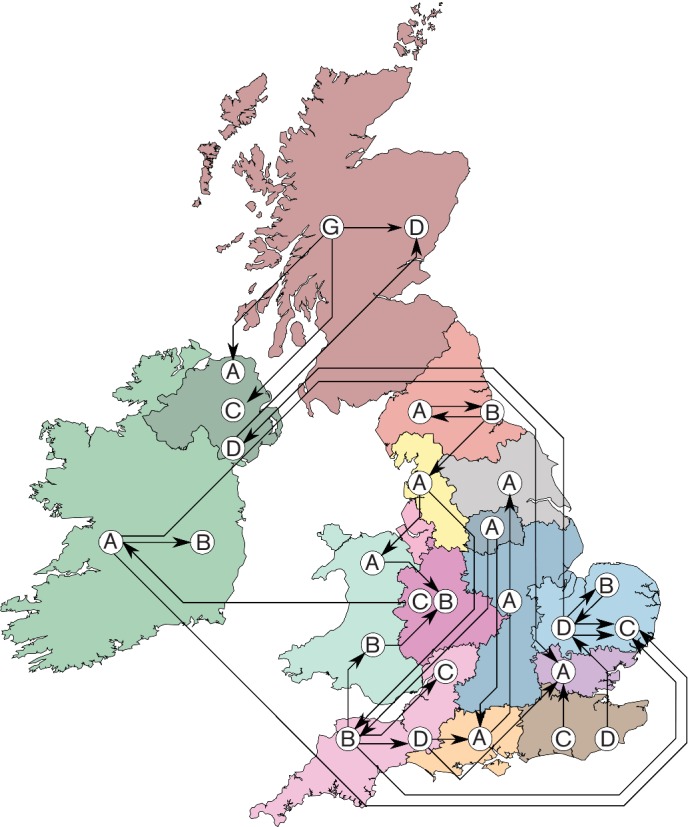
Possible introductions of MRSA between hospital populations can be inferred from the phylogeny. Arrows show introductions between hospitals (Indicated by letters per region), from the predominant hospital of the clade to the hospital that submitted the discordant isolate. While most possible introductions occur within the same region or between neighbouring regions, a number of introductions span considerable distances.